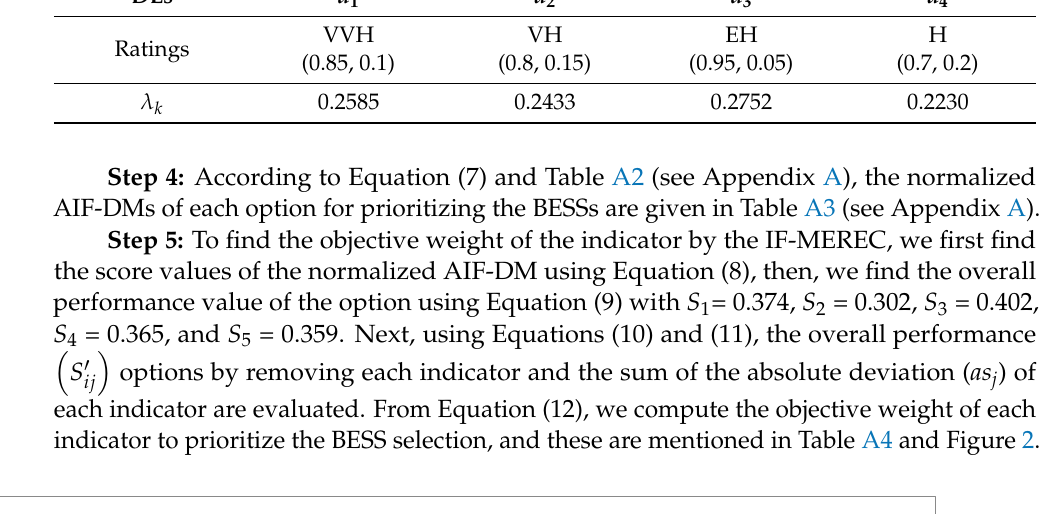
Table 3. The DE’s weight for prioritizing BESS.